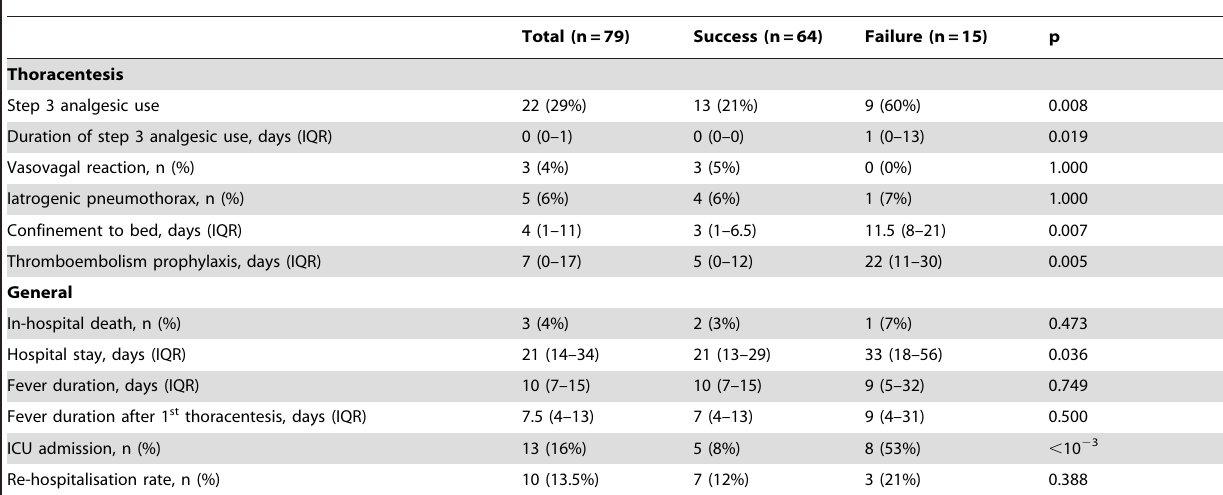
Table 4. Complications during hospitalisation.